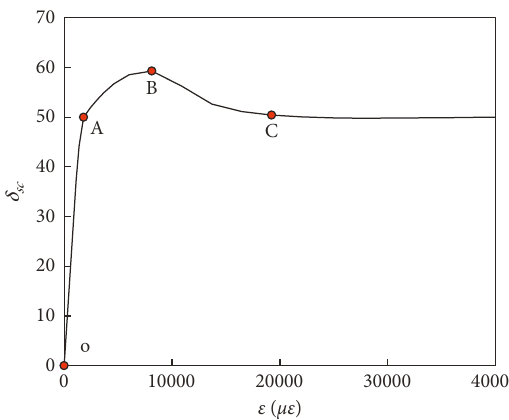
Figure 11: Typical δ